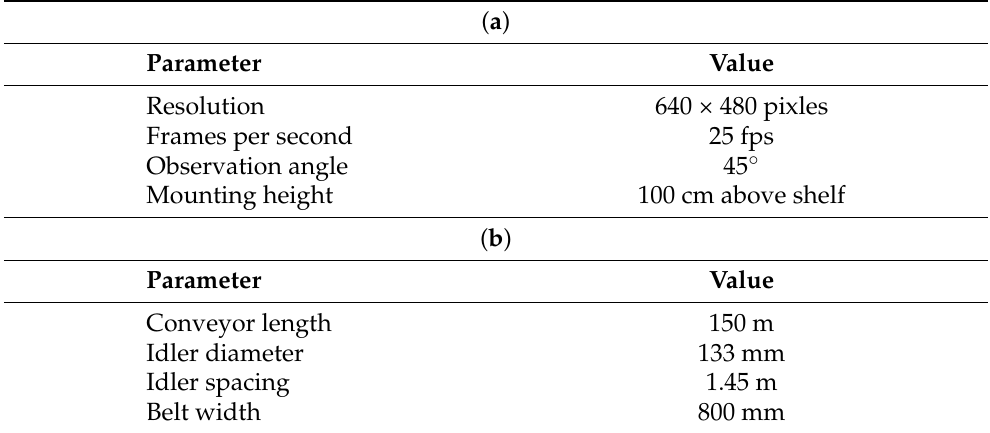
Table 2. ( a ) The camera system parameter, ( b ) Belt conveyor